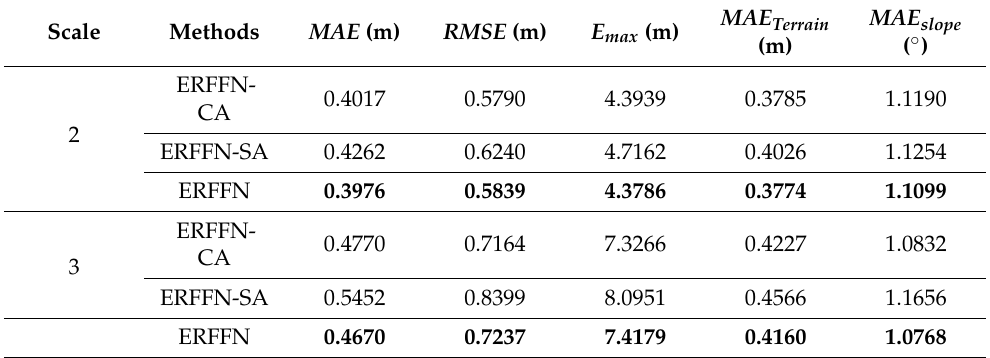
Table 5. Comparison of the performance of different attention modules for various reconstruc- tion